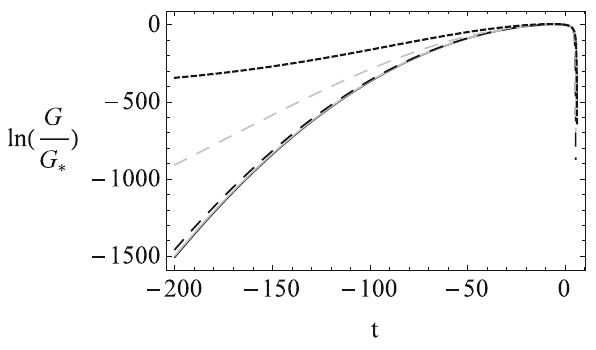
Fig. 7 The flow of the induced Newton constant. Here we plot ln ( G / G ∗ ) for the case f 2 ∗ = 10 − 8 , λ ∗ = 0 . 1, ρ ∗ = 1 . 5 and (cid:2) = 10 − 16 . The flow is computed for five different values of ξ ∗ = 10 2 (black solid line), 10 3 (grey solid line), 10 4 (big dashed black line), 5 × 10 4 (big dashed grey line) and 10 5 (small dashed black line). Both in UV and